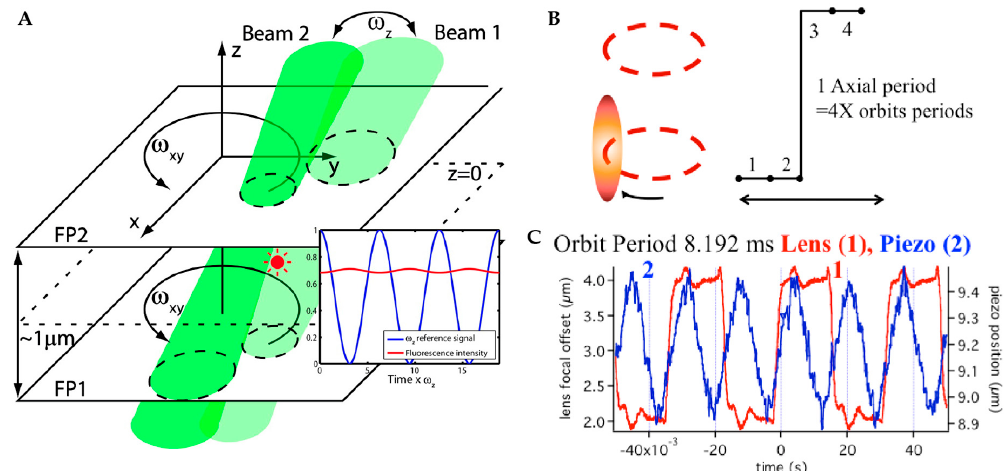
10 of 26 Figure 7. Orbital tracking with biplane detection. ( a ) Schematic of particle position measurement. The laser focus is scanned in a circle around the tracked particle while the two detection channels monitor the intensity at two axial planes (right panel). The X and Y positions of the particle are calculated from the modulation amplitude and phase of the fluorescence signal. The Z position is calculated by the difference of the signal between the two detection channels. Reprinted from reference